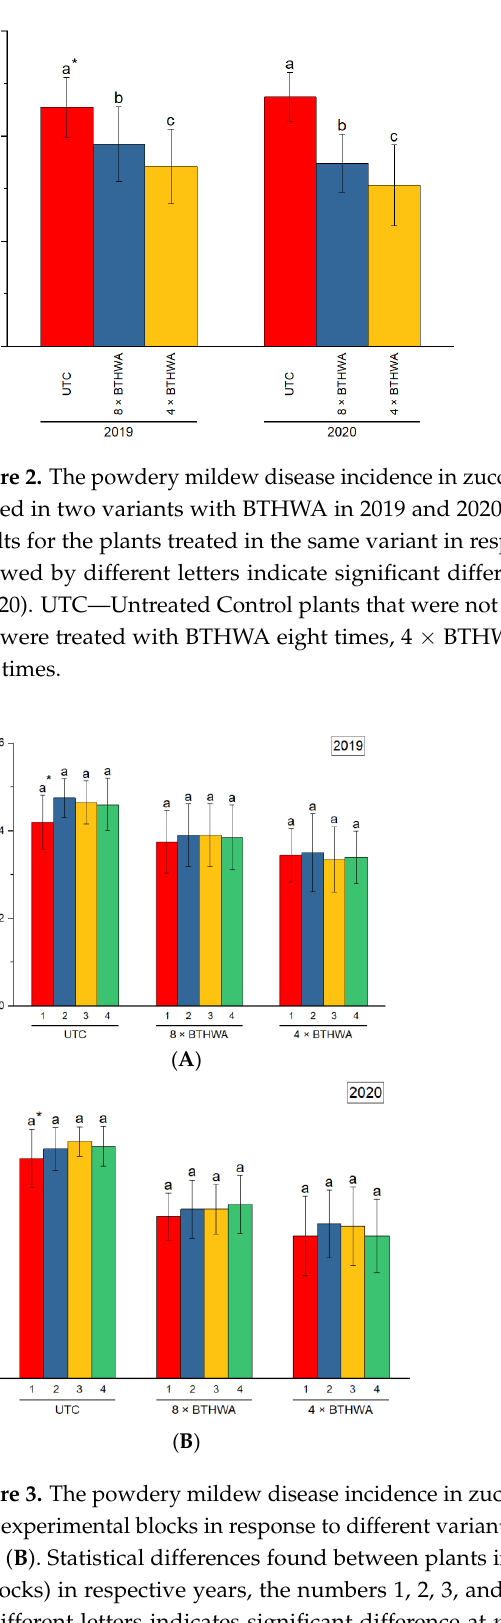
Figure 3. The powdery mildew disease incidence in zucchini ( Cucurbita pepo convar. giromontiina ) for four experimental blocks in response to different variants of treatment with BTHWA in 2019 ( A ) and 2020 ( B ). Statistical differences found between plants in different experimental blocks (treatments × blocks) in respective years, the numbers 1, 2, 3, and 4 represent four blocks. * means followed by different letters indicates significant difference at p < 0.05 according to Tukey’s HSD ( n = 20). UTC—Untreated Control plants that were not treated with BTHWA, 8 × BTHWA—plants that were treated with BTHWA eight times, 4 × BTHWA—plants that were treated with BTHWA four